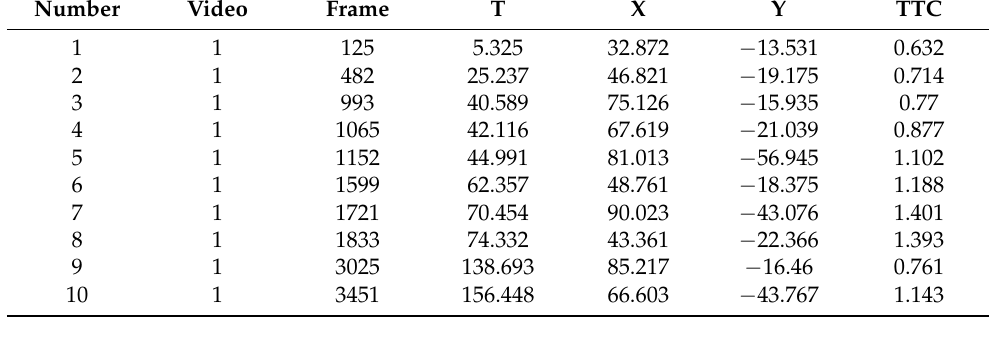
Table 3. Conflict data information.